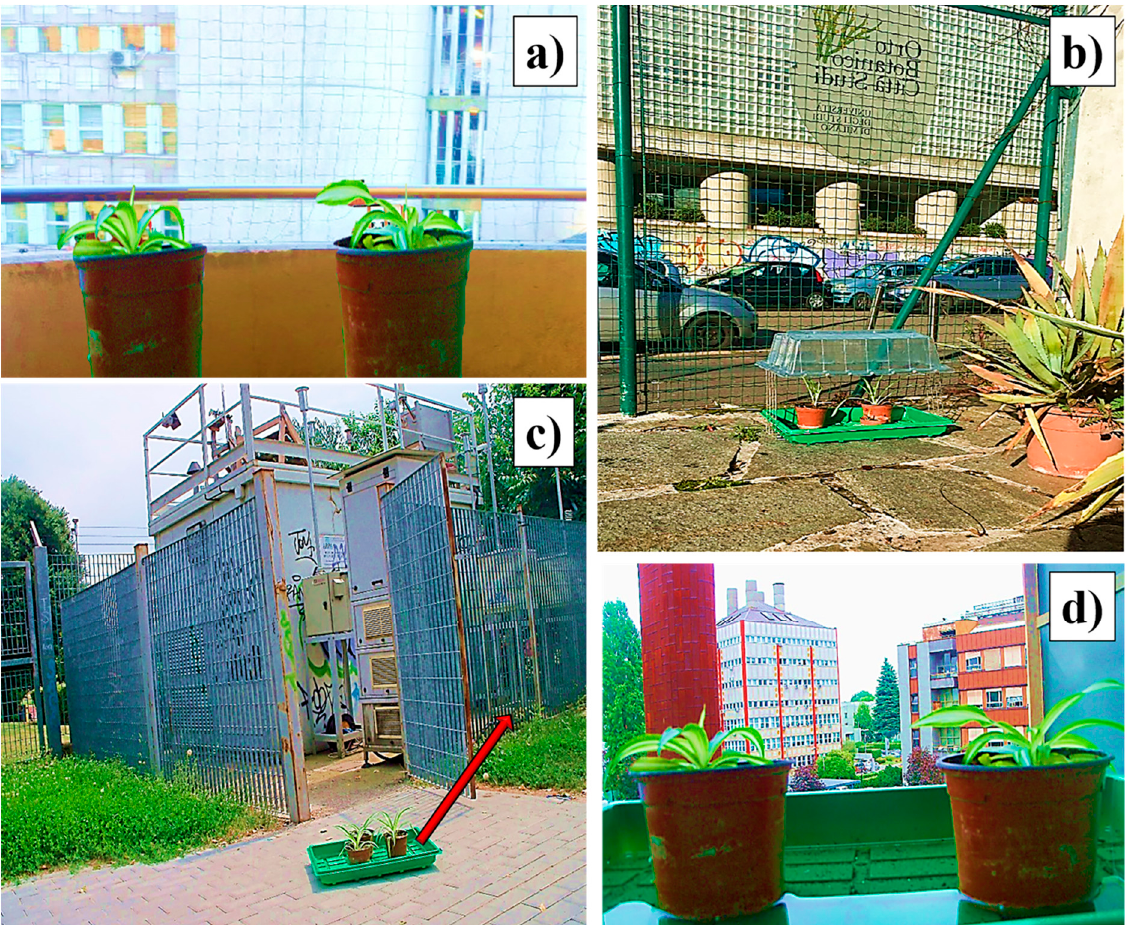
Figure 1. Some of the investigated locations; ( a ) Bioscience Department; ( b ) Botanical Garden; ( c ) ARPA Lombardia monitoring station; ( d ) Chemistry Department. In all the sites plants were located sheltered from water: in case of site ( a , d ) they were placed on a protected balcony; in case of ( b ) a suitable plastic cover has been created to protect the plants from direct runoff; in case of ( c ) the plants were placed, as indicated by the red arrow, below the two gravimetric PM samplers inside the enclosure of the ARPA monitoring station.